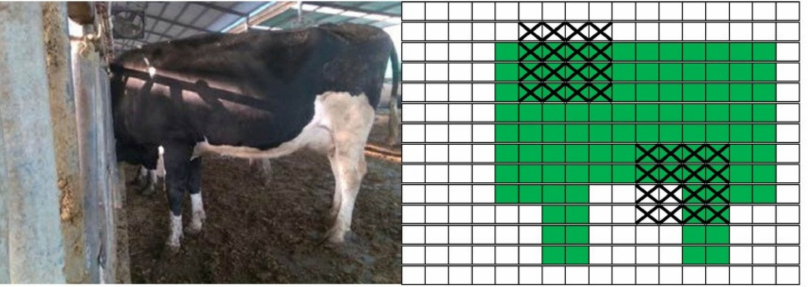
Figure 9. DropBlock2D